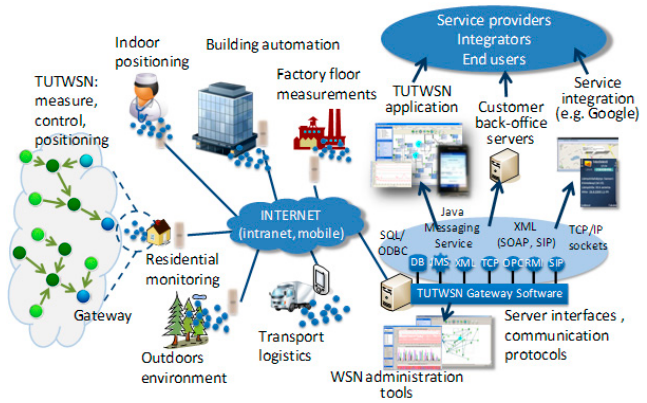
Figure 5. The architecture of a typical wireless sensor network.